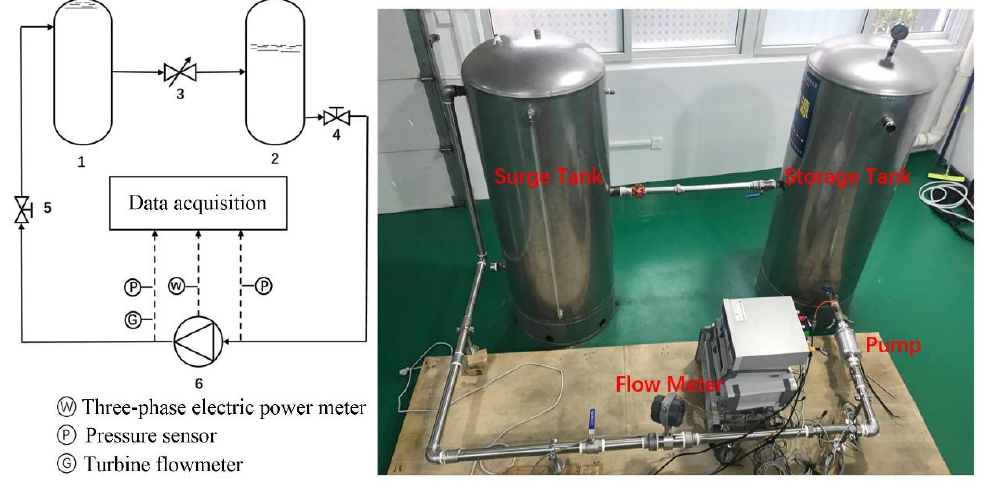
Figure 5. High-speed Pump Test Rig.